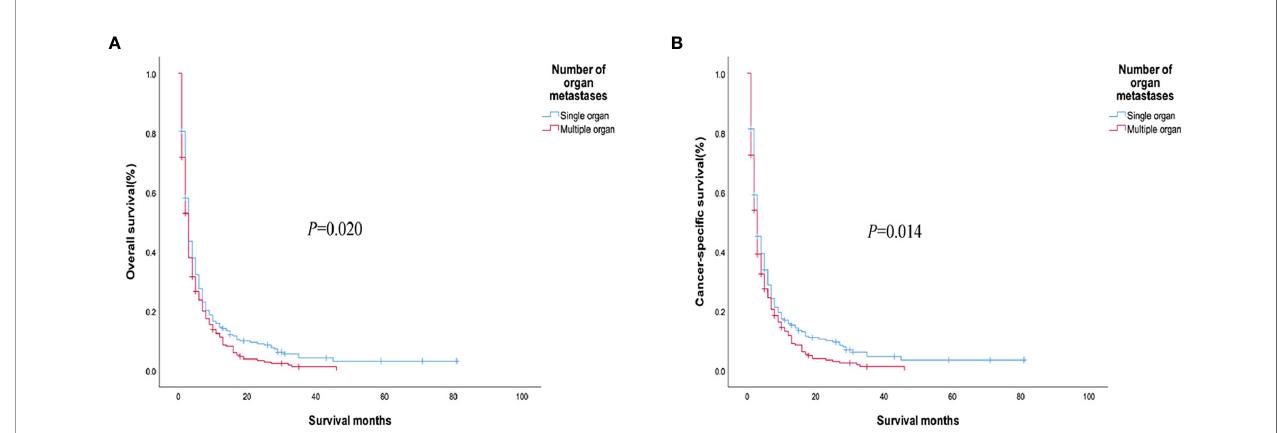
FIGURE 7 | (A) Overall survival and (B) cancer-speci fi c survival curves of patients with different numbers of metastatic organs